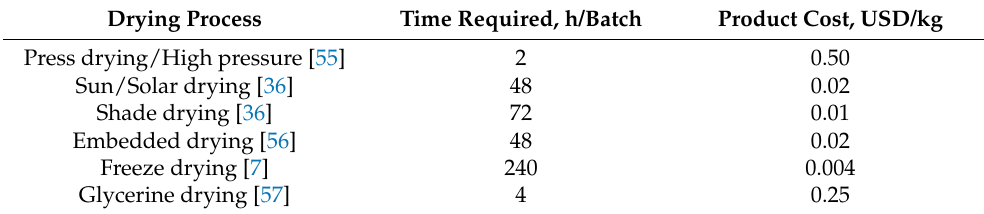
Table 7. Product cost for drying processes.